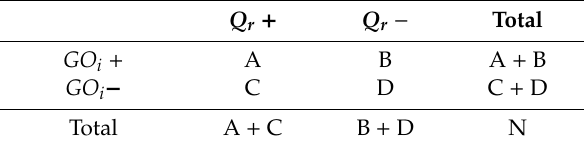
Table 1. The contingency table for Fisher’s exact test to estimate the enrichment of a Gene Ontology (GO) term in a gene set that responds to a stimulus within specific fold-change interval Q